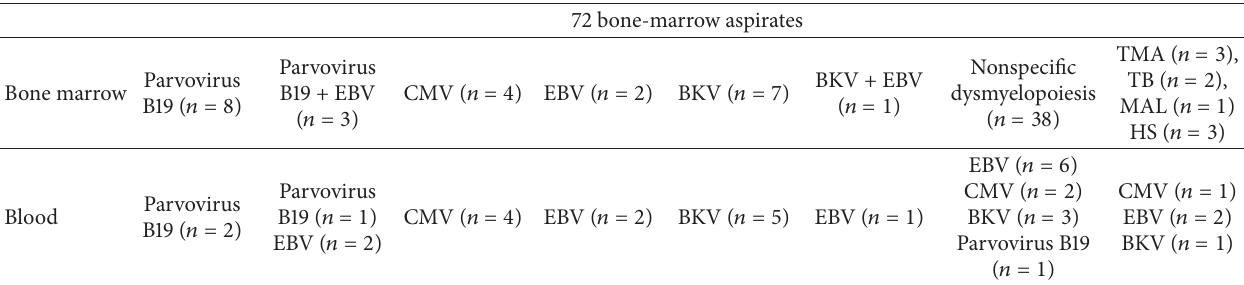
Table 2: Viral replication in bone marrow and blood from kidney-transplant patients with a hematological disorder. 72 bone-marrow